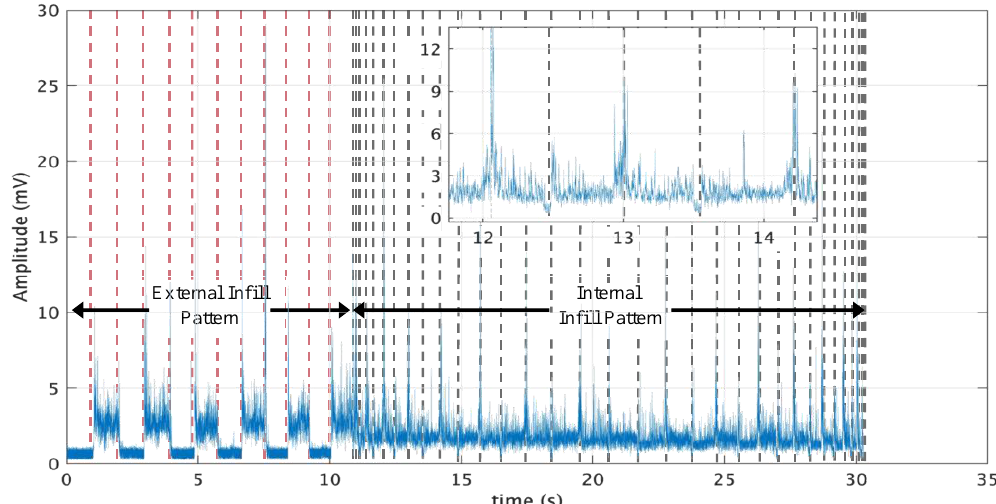
Figure 4. RMS AE signals during the fabrication of the part.